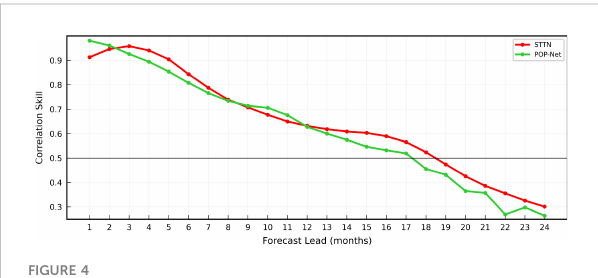
FIGURE 4 ENSO predicts all-season Temporal Anomaly Correlation Coef fi cient Skill (ACorr) in the STTN model.The ACorr of the three-month- moving-averaged Nino3.4 index index with Several lead times